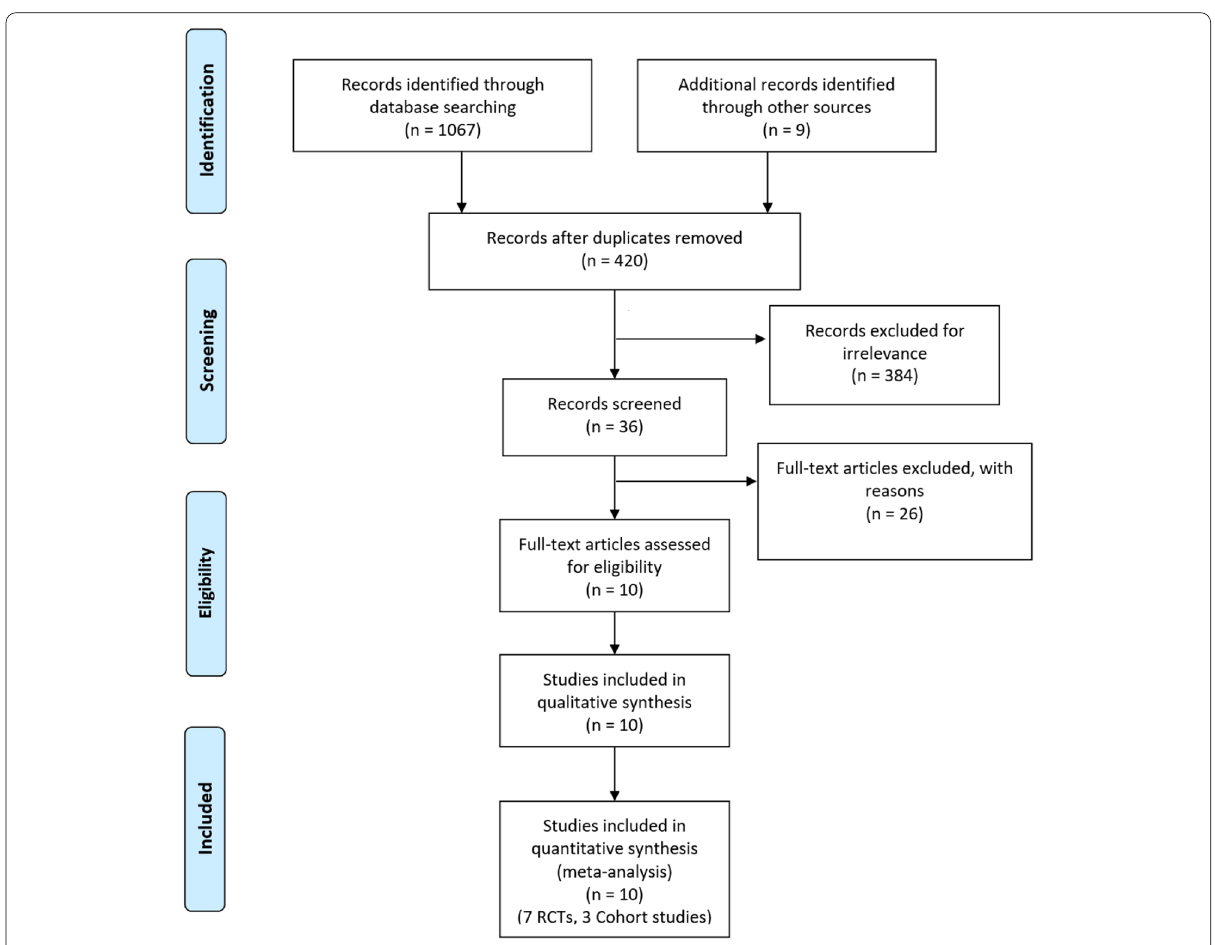
Fig. 1 Showing the PRISMA flowchart of the study search